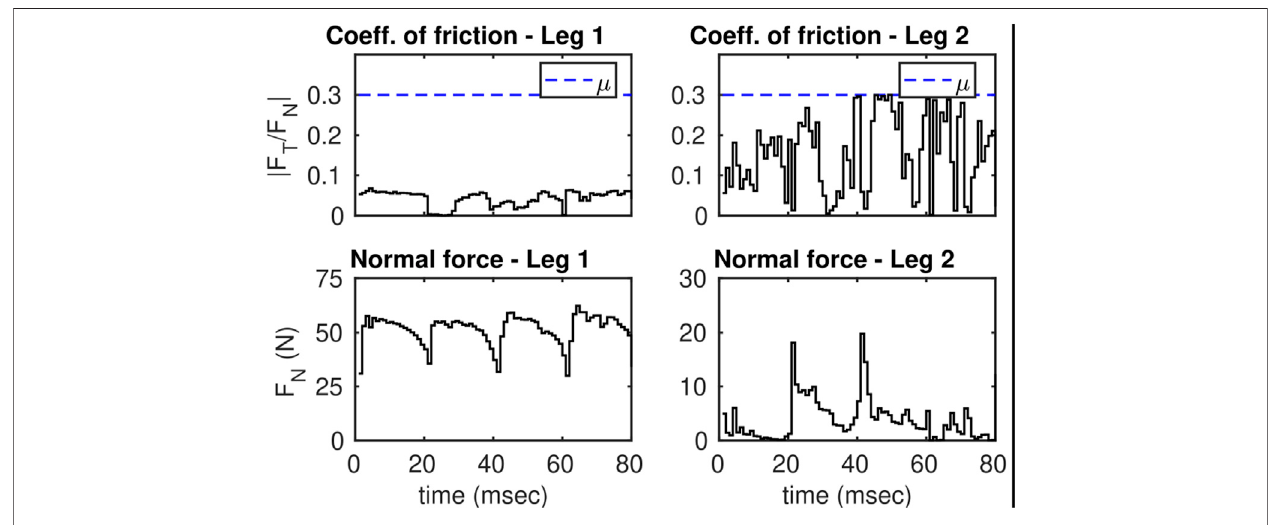
FIGURE 13 | Illustrates the reference joint velocity trajectories in the 3-link ROM.